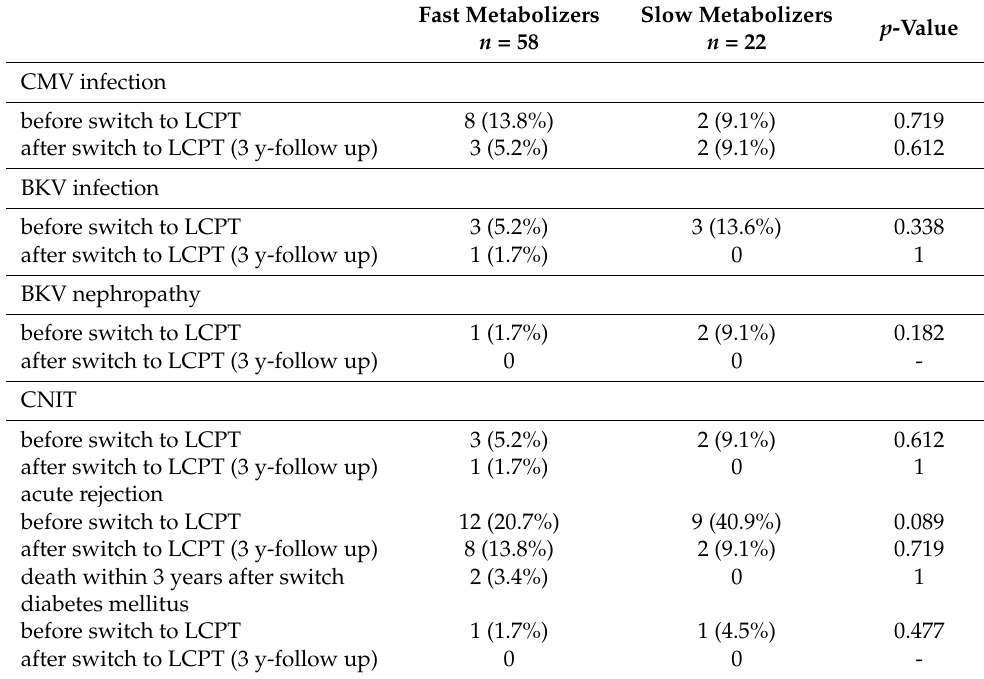
Table 4. Complications before and after